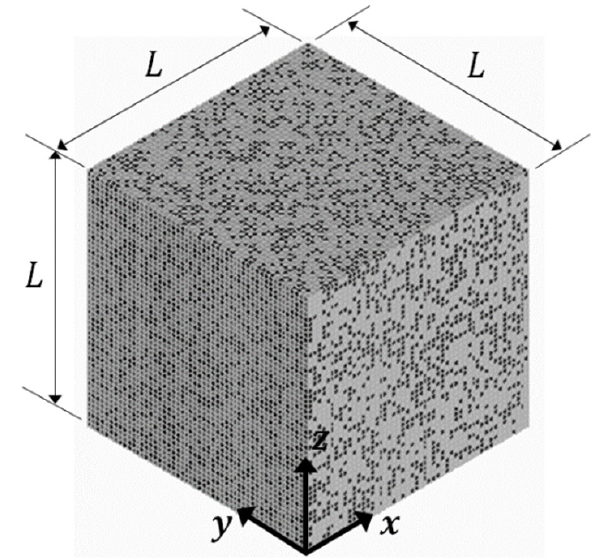
Figure 1. Representative volume element used in MF-FEM. The RVE is in a cubic shape and the dimensionless side length is L = 100, and the element size is 2. Therefore, the size ratio between the elements and the RVE is 1:50, which is smaller than the threshold, such that the shape and size of inclusions have no effect on the elastic properties of the RVE. The task of the MF-FEM is to characterize the